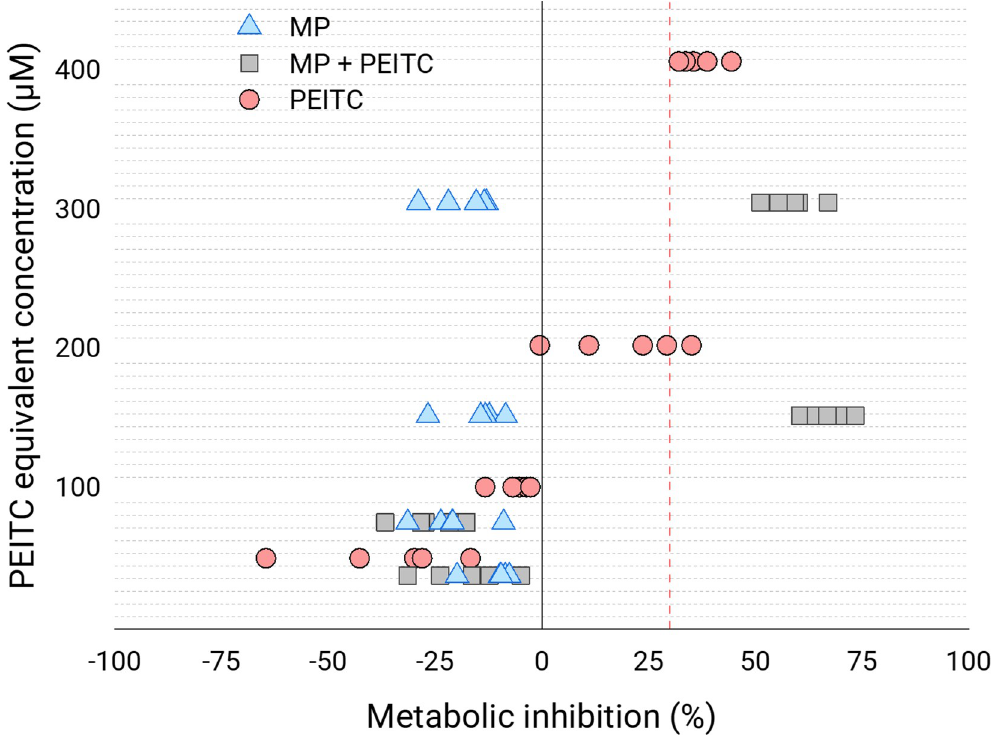
Fig 8. Biocompatibility. Metabolic inhibition of empty MPs, MPs with PEITC (MP + PEITC) and pure PEITC at different equivalent concentrations of PEITC (38, 77, 153 and 306 μ M for MP and MP + PEITC; 51, 102, 204 and 408 μ M for pure PEITC) for 24 h against human colorectal adenocarcinoma Caco-2 cells. The scatter of independent determinations (n = 5) are represented. The dashed red vertical line represents the 30% inhibition limit.